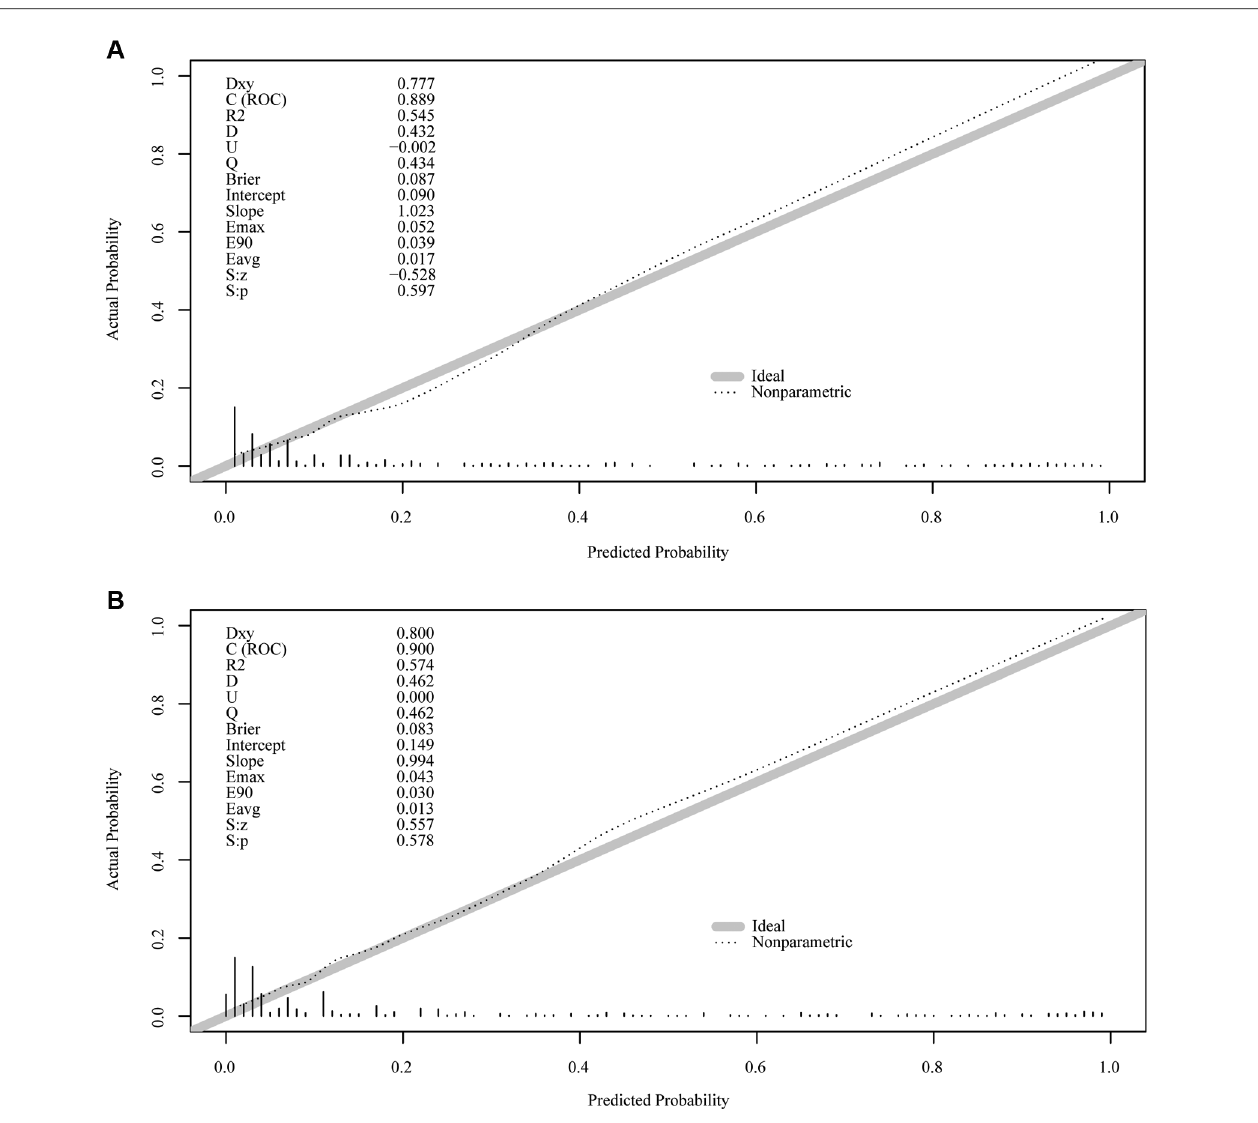
FIGURE 6 External veri fi cation plots of ROMA and CPH-I nomogram veri fi cation curves. ( A ) Nomograms with ROMA; ( B ) nomograms with